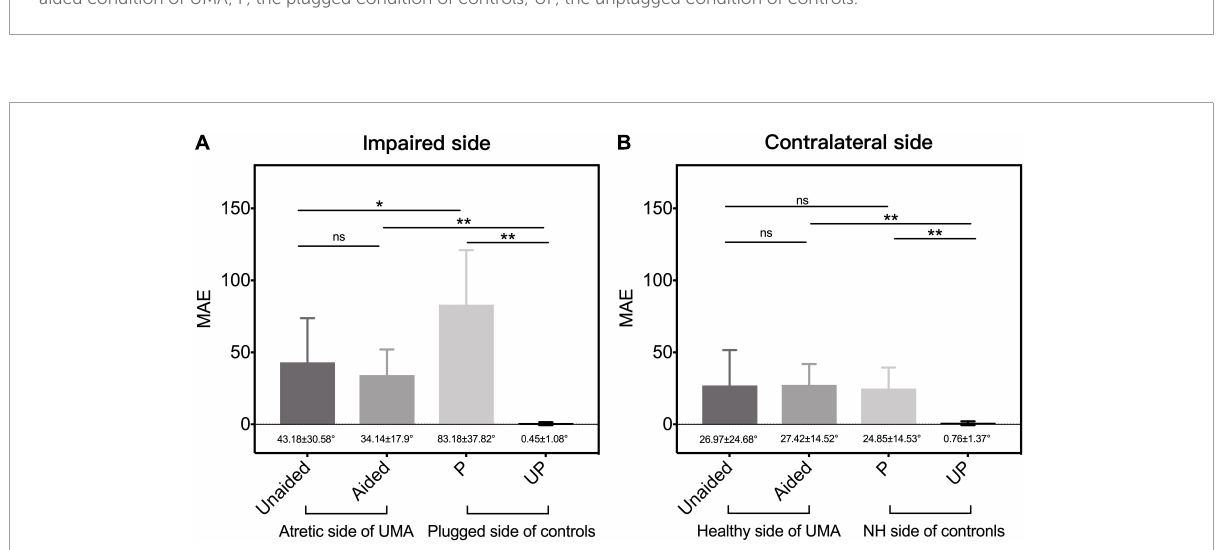
FIGURE6 The mean MAE of patients with UMA and the controls, respectively, on (A) the impaired (including the atretic side of UMA and the plugged side of controls) side and the (B) contralateral (the healthy side of UMA and the unplugged side of controls) side. Error bars represent mean ± SD . Significant differences, * p < 0.05, ** p < 0.01. ns, not significant; UMA, unilateral microtia and atresia; MAE, mean absolute error; Unaided, the unaided condition of UMA; Aided, the aided condition of UMA; P, the plugged condition of controls; UP, the unplugged condition of controls; NH, normal hearing; SD , standard